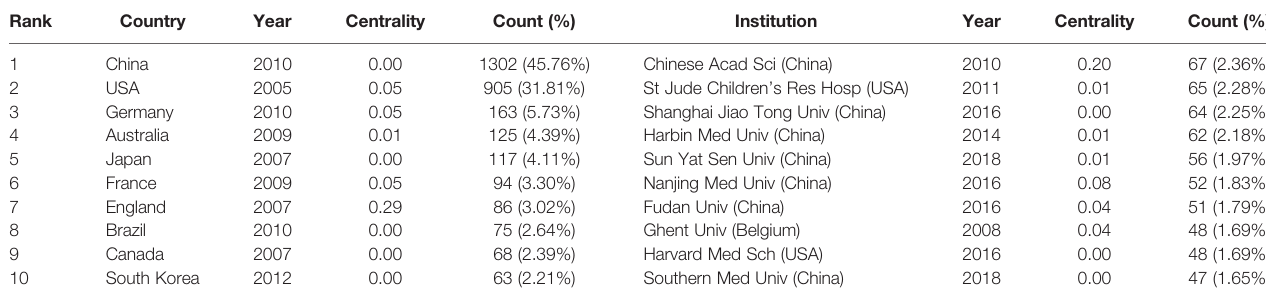
TABLE 1 | Top 10 countries/regions and institutions related to